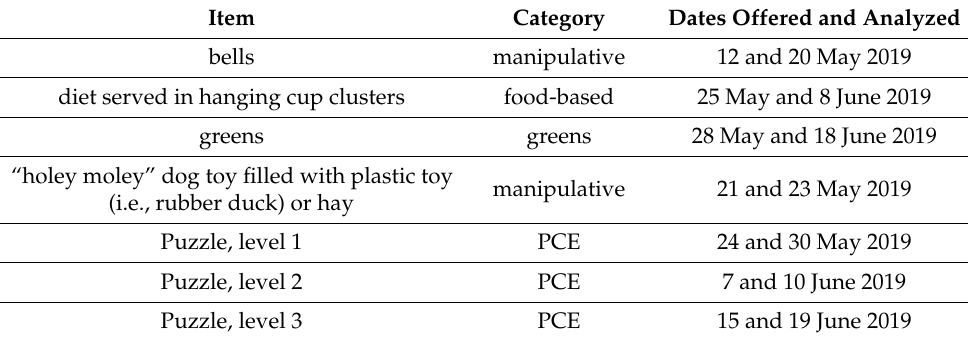
Table 3. Enrichment items selected for analysis with dates